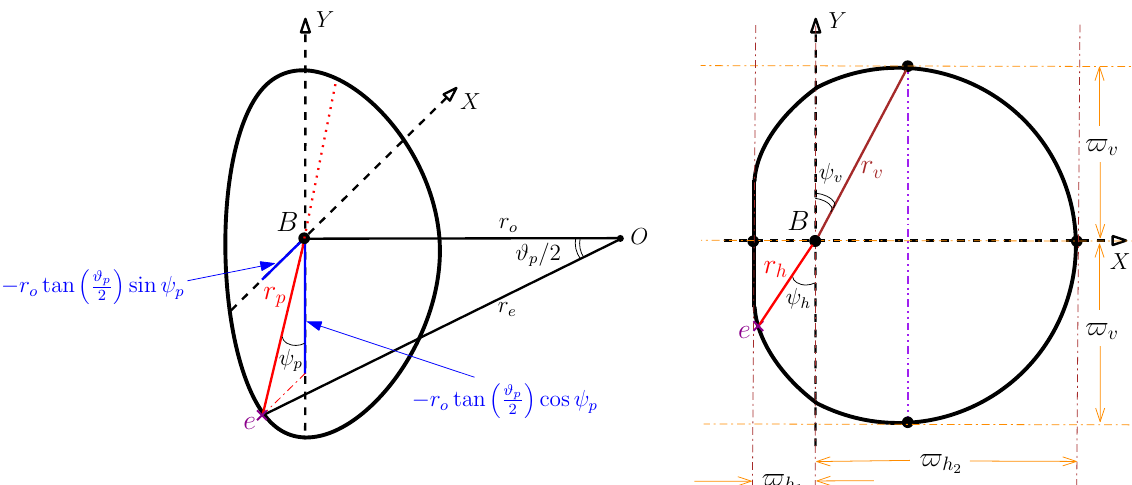
Figure 8. Characterization of an oblate shadow in terms of the angular diameters. The celestial coordinates ( ψ p , ϑ p ) are transformed into the Cartesian coordinates ( X , Y ) , as indicated in the left panel. The black hole at point B is located at the center of the Cartesian coordinates. The observer at point O and at the distance r o from the black hole, observes the event e on the shadow. In the right panel, and following the method given in [113], the angular diameters corresponding to the mentioned celestial coordinates, are now expressed in terms of three angular radii (cid:118) h symmetry with respect to the X